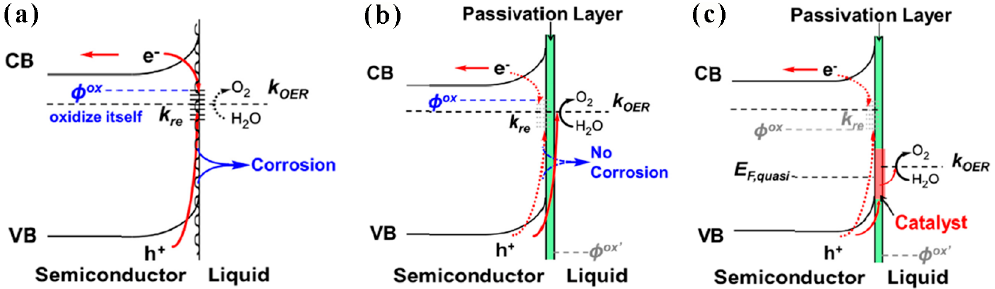
Figure 4. ( a , b ) Comparison of an n ‐ type semiconductor photoelectrode with/without a stabilizing passivation layer and with/without corrosion in contact with an aqueous electrolyte. Corrosion may reduce the light absorption and/or generate more surface defect states, which results in a more positive onset potential and a reduced photocurrent; ( c ) Schematic illustration of the band structure of a surface passivation layer on an n ‐ type semiconductor. The photogenerated holes near the surface are in competition with the trap site induced recombination of majority ‐ carriers (e − ) and the charge transfer to the surface layer. The surface recombination rate ( k re ) and electrode corrosion are suppressed on the passivation surface and the interfacial charge ‐ transfer rate for water oxidation ( k OER ) is improved. Reproduced and adapted with permission of from [85]. Copyright The Royal Society of Chemistry, 2014.